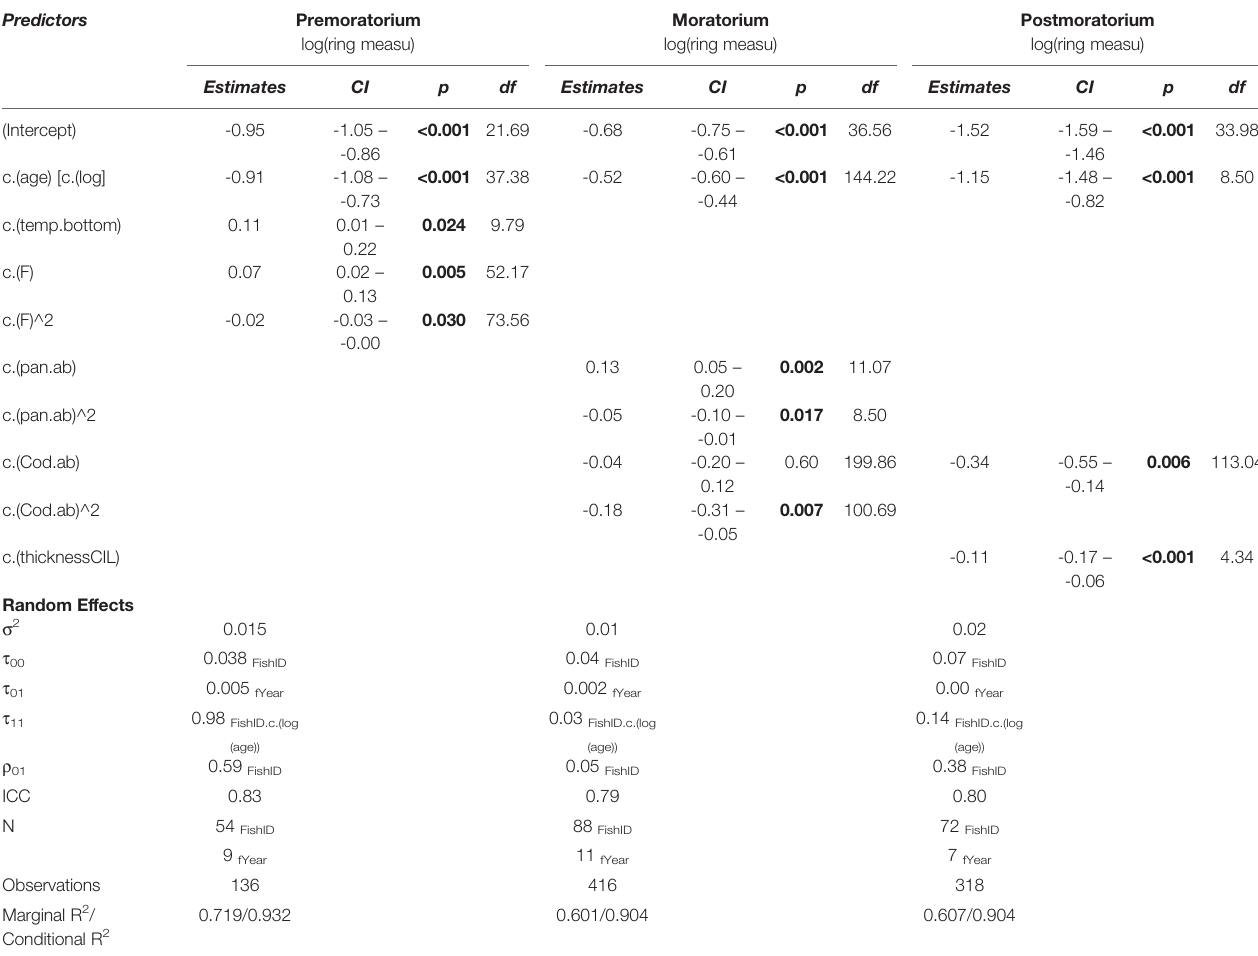
TABLE 2 | Parameter estimates of fi xed and random factors for the best model describing growth variantion in Femish Cap cod for the three periods of different fi shing intersity: Premoratorium (1988-1998), Moratorium (1999-2009) and Postmoratorium (2010-2016).